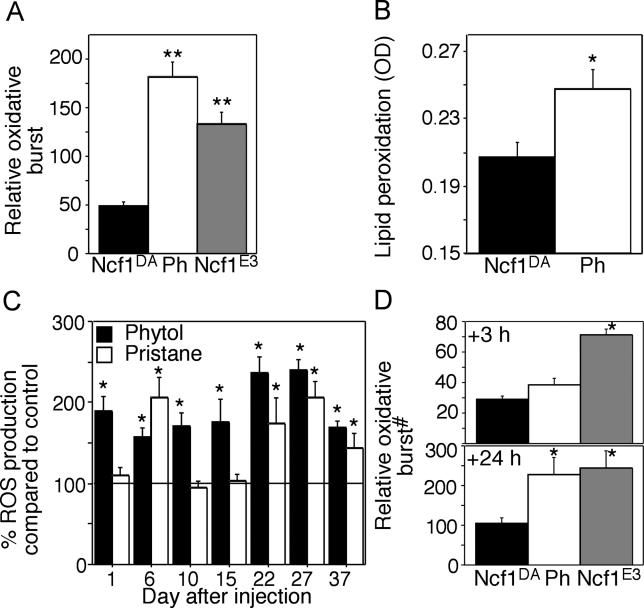
Phytol Increases Oxidative Bursts In Vivo(A) Phytol (Ph) restores the oxidative burst in vivo. Oxidative burst response to PMA stimulation in vitro in spleen granulocytes taken 5 d after SC phytol injection in DA.Ncf1
DA rats (200 μl) or from naïve DA.Ncf1
E3 compared to naïve DA.Ncf1
DA (n = 5).(B) Increased levels of products from lipid peroxidation in serum after phytol injection. Sera were taken 5 d after SC phytol injection in DA.Ncf1
DA and analyzed for levels of malondialdehyde, which reflects lipid peroxidation (n = 4).(C) Phytol injection has a long-term effect on oxidative burst capacity of granulocytes. Capacity of DA.Ncf1
DA blood granulocytes to exert an oxidative burst in response to PMA stimulation in vitro after SC injection of phytol or pristane (200 μl) on day 0. Values are presented as percent of oxidative burst compared naïve DA.Ncf1
DA rats (represented by the line) (n = 5).(D) Phytol increases the oxidative burst capacity in BM granulocytes. Oxidative burst capacity of granulocytes from BM taken 3 hours (n = 5) and 24 hours (n = 4) after SC phytol (Ph; 200 μl) injection in DA.Ncf1
DA rats or from naïve DA.Ncf1
E3, compared to naive DA.Ncf1
DA. #Experiments were performed independent of each other and levels should thus not be compared.*p < 0.05, **p < 0.01.